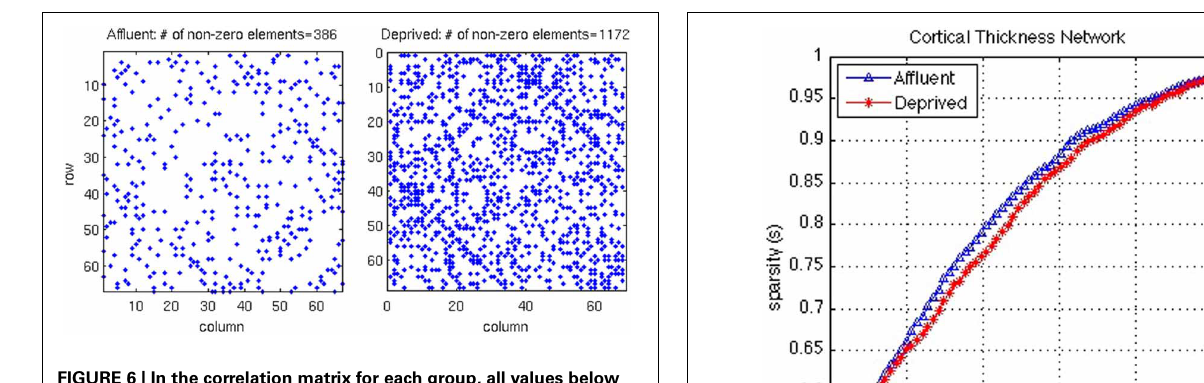
FIGURE 6 | In the correlation matrix for each group, all values below the FDR threshold are set to zero, where. About three-times more edges survived the FDR procedure in the most deprived than the least deprived group. Affluent: Least deprived; Deprived: Most deprived.